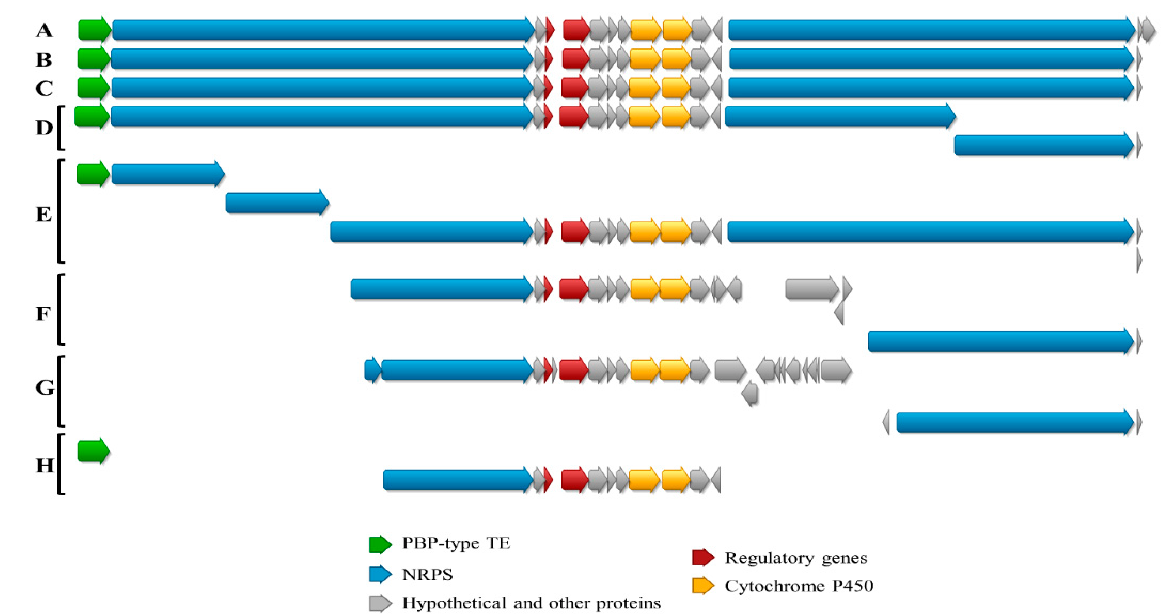
Figure 8. Schematic representation of the alignment of cpp BGC from Streptomyces cacaoi CA-170360 and the homologous genome sequences found in NCBI. A, S. cacaoi CA-170360; B, S. cacaoi NHF165; C, S. cacaoi DSM 40057; D, S. cacaoi NRRL B-1220; E, S. cacaoi OABC16; F, Streptomyces sp. NRRL S-1868; G, Streptomyces sp. NRRL F-5053 and H, S. cacaoi NBRC 12748. Due to the high fragmentation in some of these S. cacaoi genomes, the corresponding BGC was found in different contigs and was not complete.